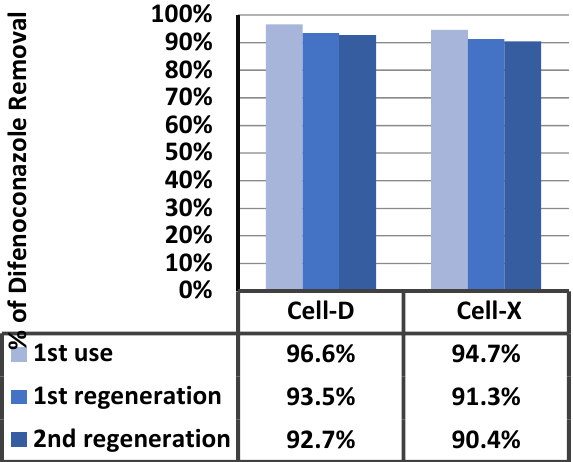
Figure 14. Adsorbent recycling results.